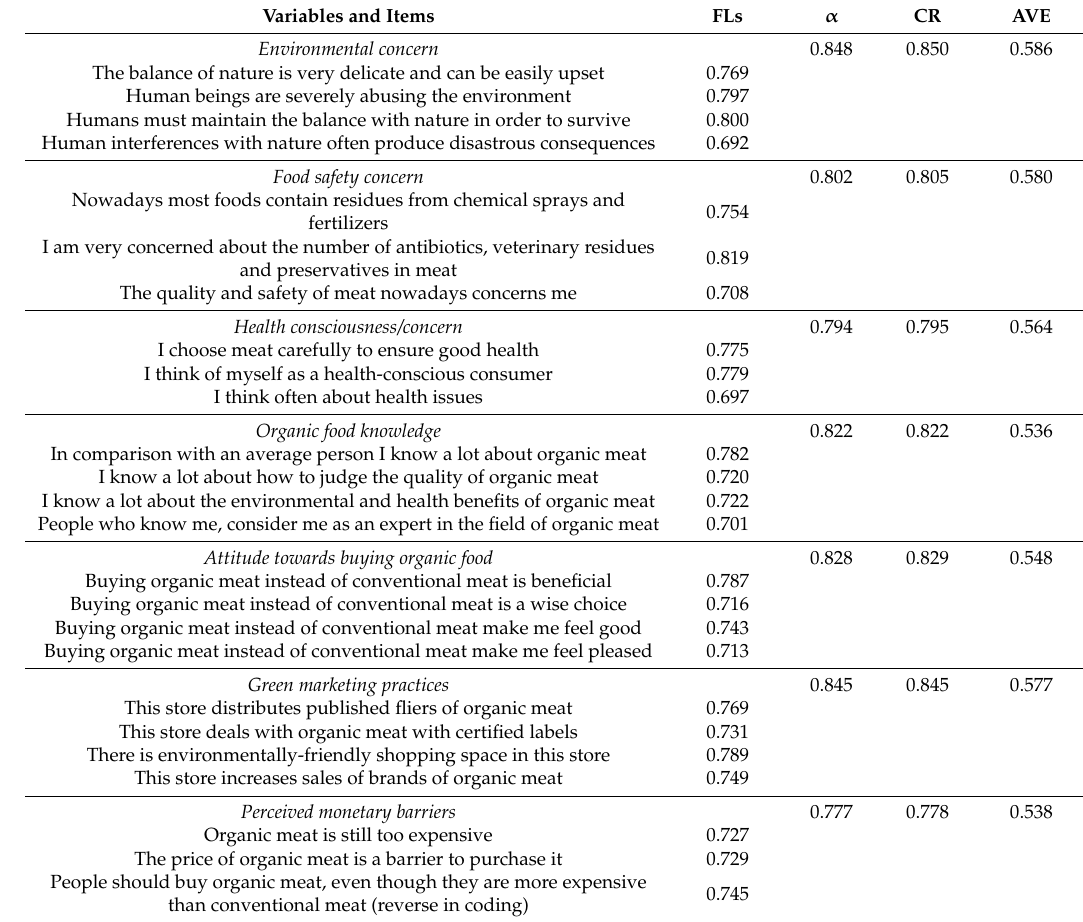
Table 2. Items, reliability and convergent